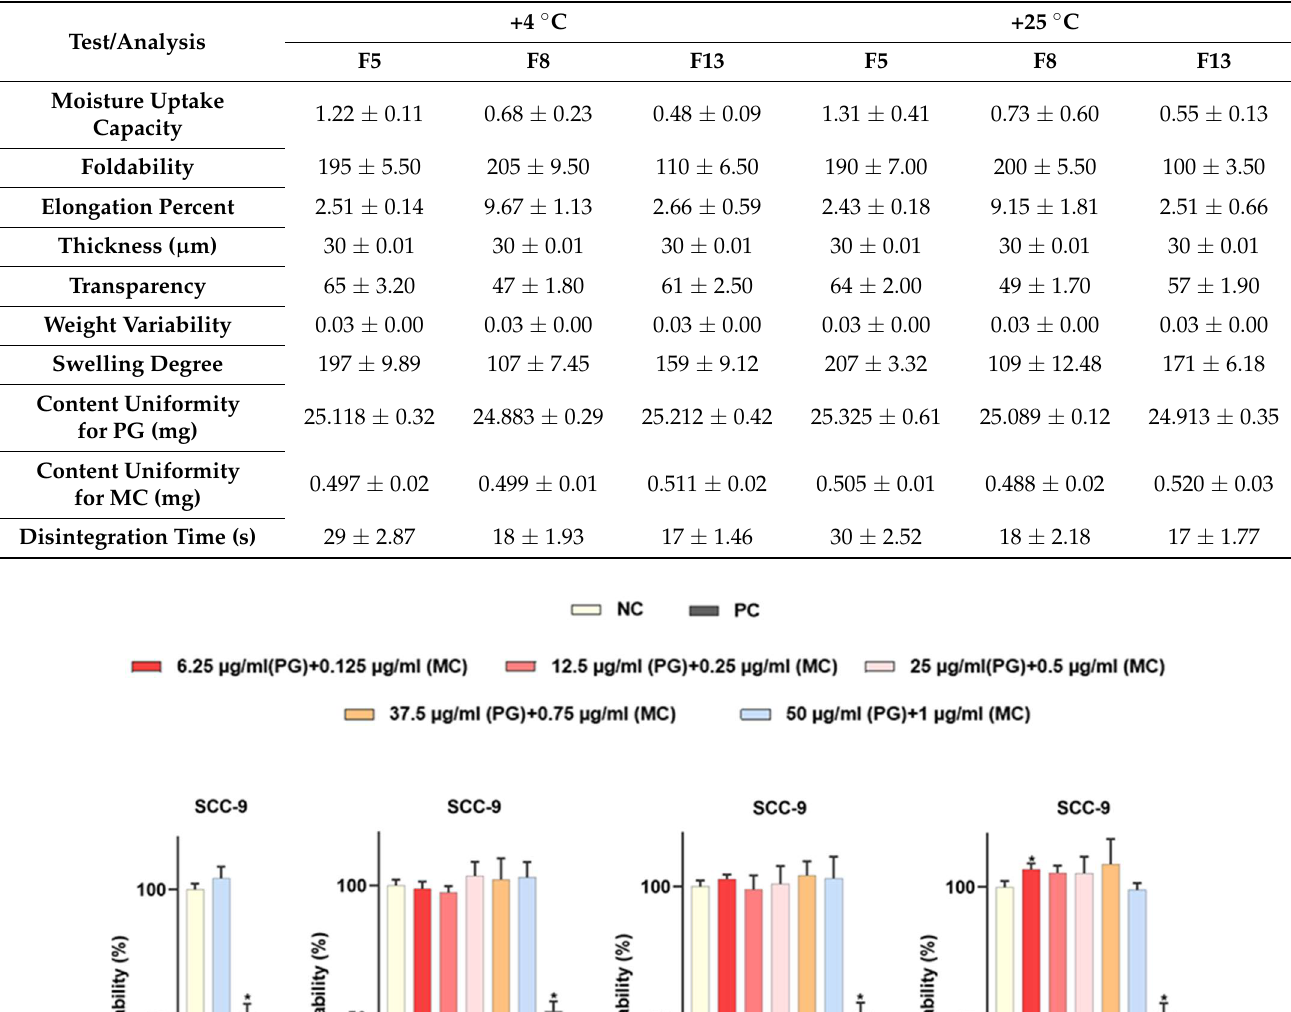
Figure 3. Blank OTFs ( left ), PG and MC included OTF ( right ).